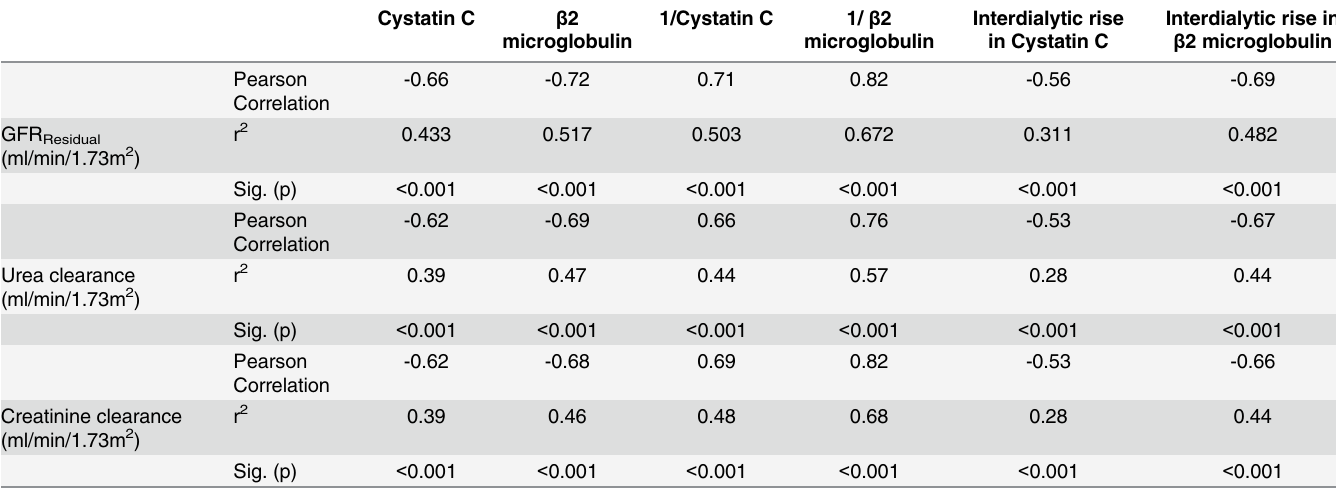
Table 4. Correlation of pre-dialysis Cystatin C and β 2 microglobulin plasma levels and their interdialytic rise with various measures of